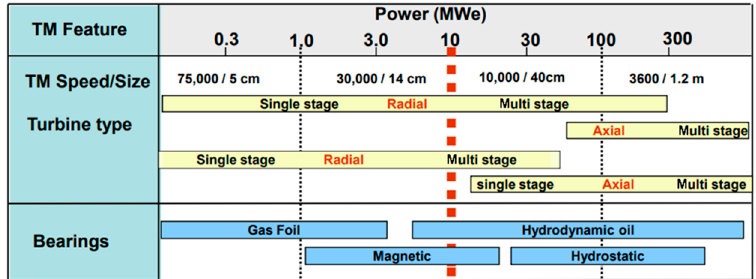
Figure 1. Bearing options for supercritical carbon dioxide (S-CO 2 ) Brayton cycles for various power scales [4].